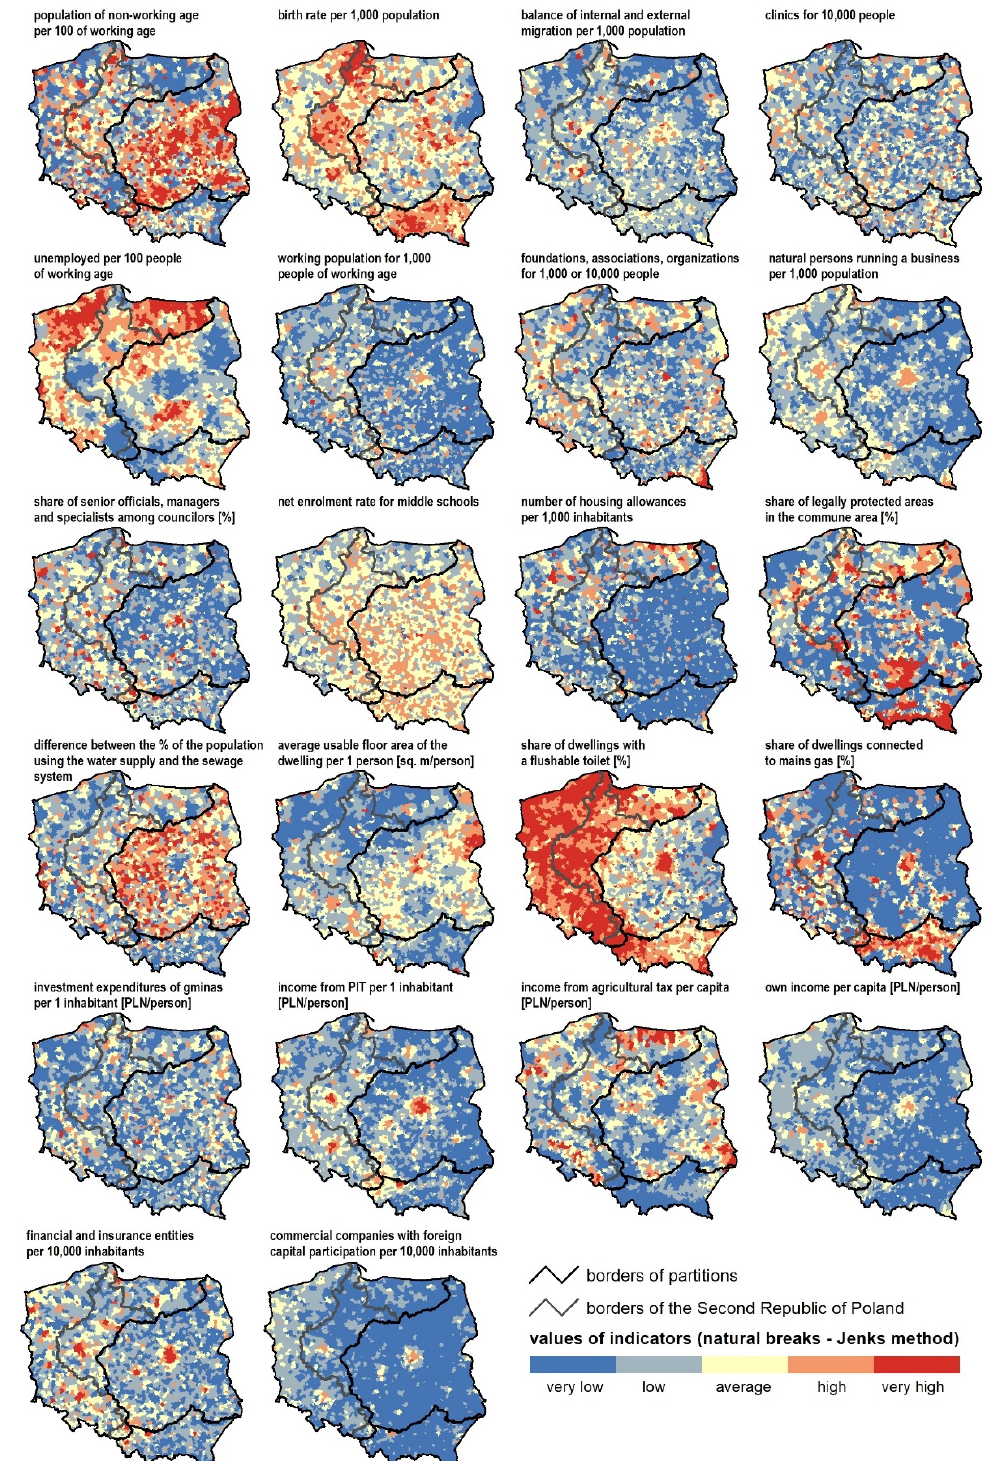
Figure 4. Spatial distribution of sub-indices in 2018. Source: own elaboration on the basis of data from the Local Data Bank of Statistics Poland.